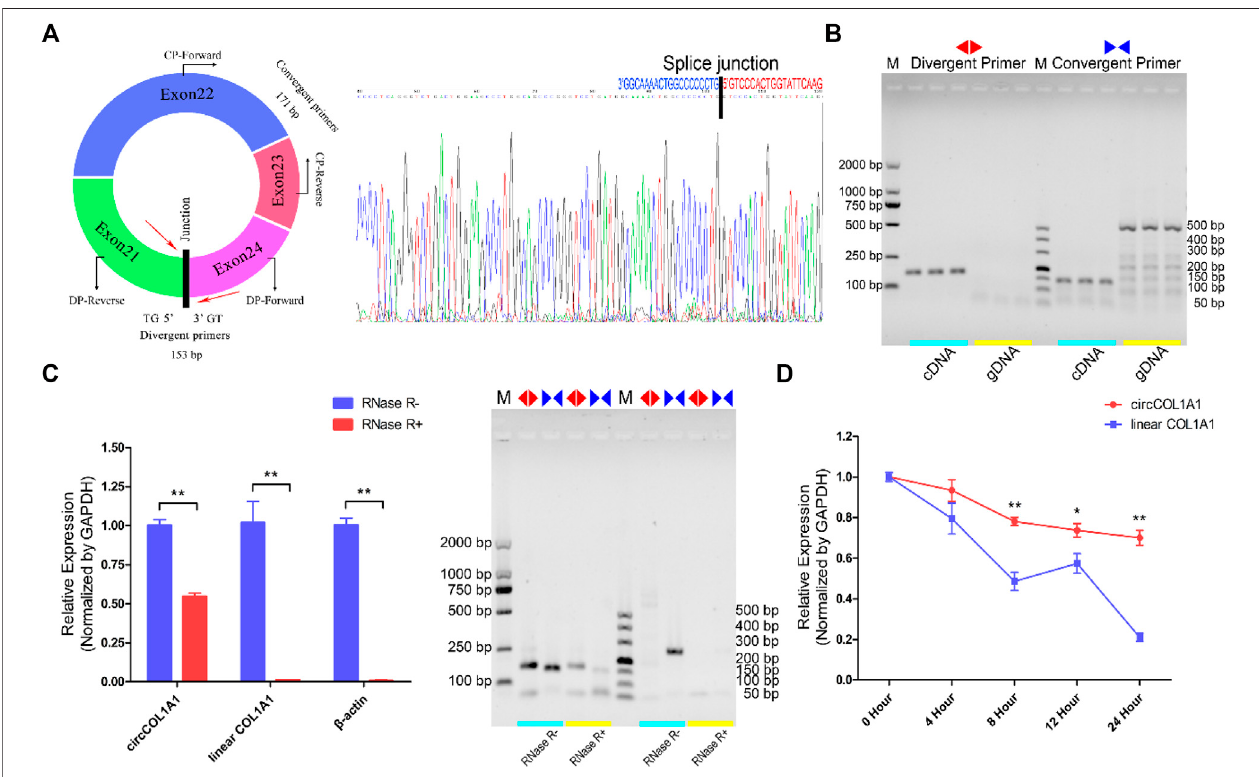
FIGURE2| Identi fi cation, characterization,and expressionpro fi le ofcircCOL1A1. (A) Thestructure andsplice junctionsitesofgoatcircCOL1A1wereidenti fi edby Sanger sequencing. (B) PCR with divergent and vonvergent primers con fi rmed the existence of circCOL1A1. (C,D) RNase R (C) and actinomycin D treatment (D) combined with RT-qPCR assays indicated that the abundance and stability of circCOL1A1 was greater than that of linear COL1A1 mRNA. (E) The expression of circCOL1A1 wasdetected in stemcell nuclei and cytoplasm. (F) Expression levels ofcircCOL1A1in 10differenttissuesin NQand SQgoats. (G) Expression levels ofcircCOL1A1andlinearCOL1A1mRNAin10differenttissuesinNQgoats. (H) ExpressionlevelsofcircCOL1A1andlinearCOL1A1mRNAin10differenttissuesinSQ goats. (I) Expression abundance of circCOL1A1 and linear COL1A1 mRNA in cervical spine skin tissues between NQ and SQ